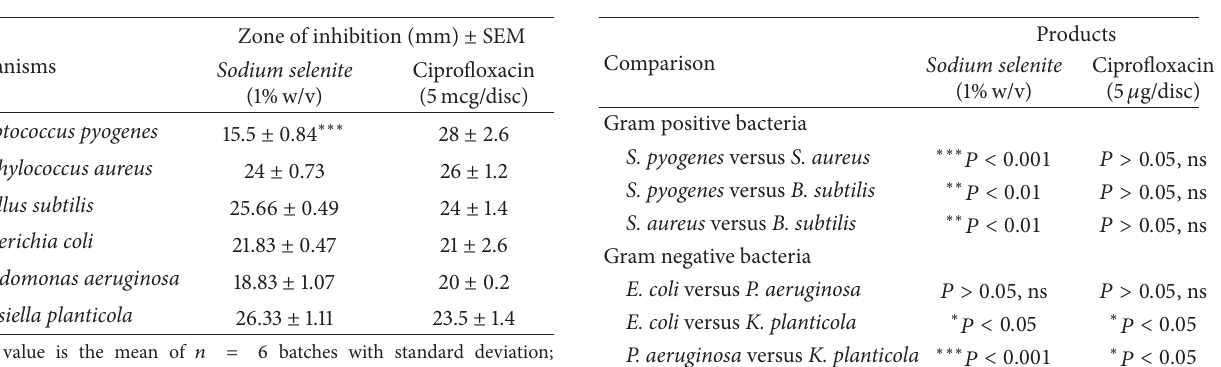
Table 1: Antibacterial effect of sodium selenite against selected human pathogenic bacteria.